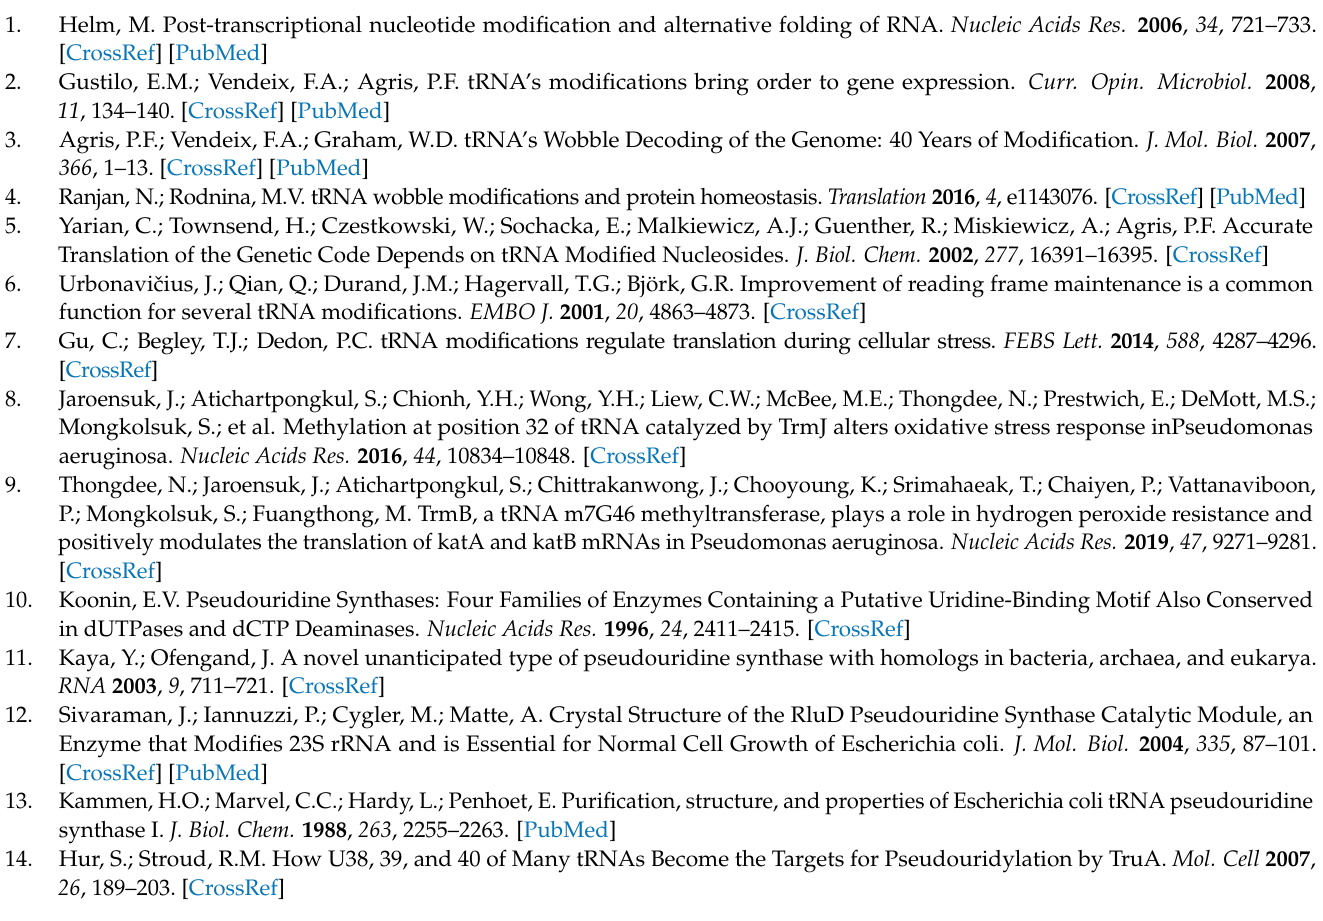
Table S9: Statistical analysis of the results of accumulation of Rif R mutants of strains growing with (+) or without ( − ) thiourea (TU). Table S10: Statistical analysis of the results of accumulation of Rif R mutants of P. putida strains lacking PP1935 or over expressing PP1935 (“ − “without IPTG and “+” with IPTG) in addition to the deletion of truA or rluA gene. Table S11: Statistical analysis of the results of accumulation of Rif R mutants of P. putida strains lacking PP5487 or over expressing PP5487 (“ − “without IPTG and “+” with IPTG) in addition to the deletion of truA or rluA gene. Table S12: Statistical analysis of the results of accumulation of Rif R mutants of P. putida strains over expressing operon PP5487-89 (“ − “without IPTG and “+” with IPTG) in addition to the deletion of truA or rluA gene. Explanatory legend for Supplementary